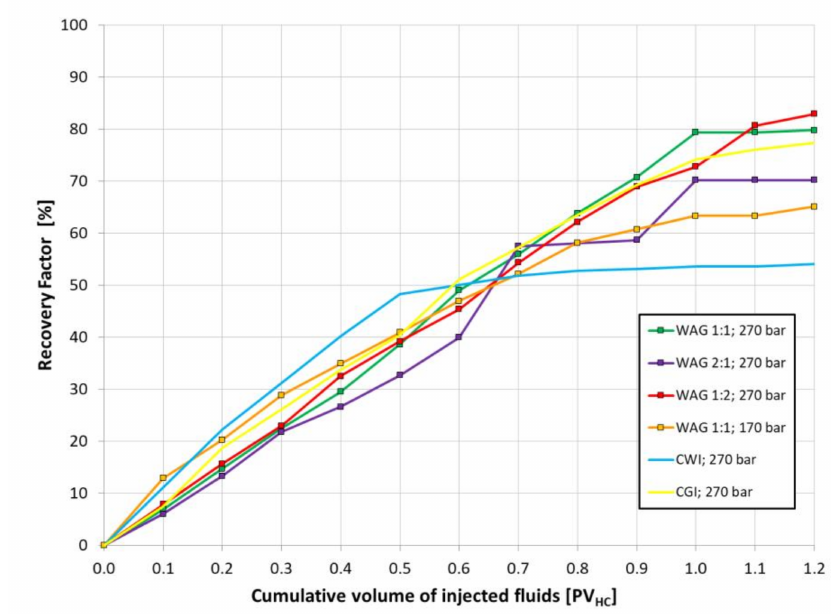
Figure 11. Oil recovery efficiency using different CO 2 -WAG schemes compared to CWI and CGI